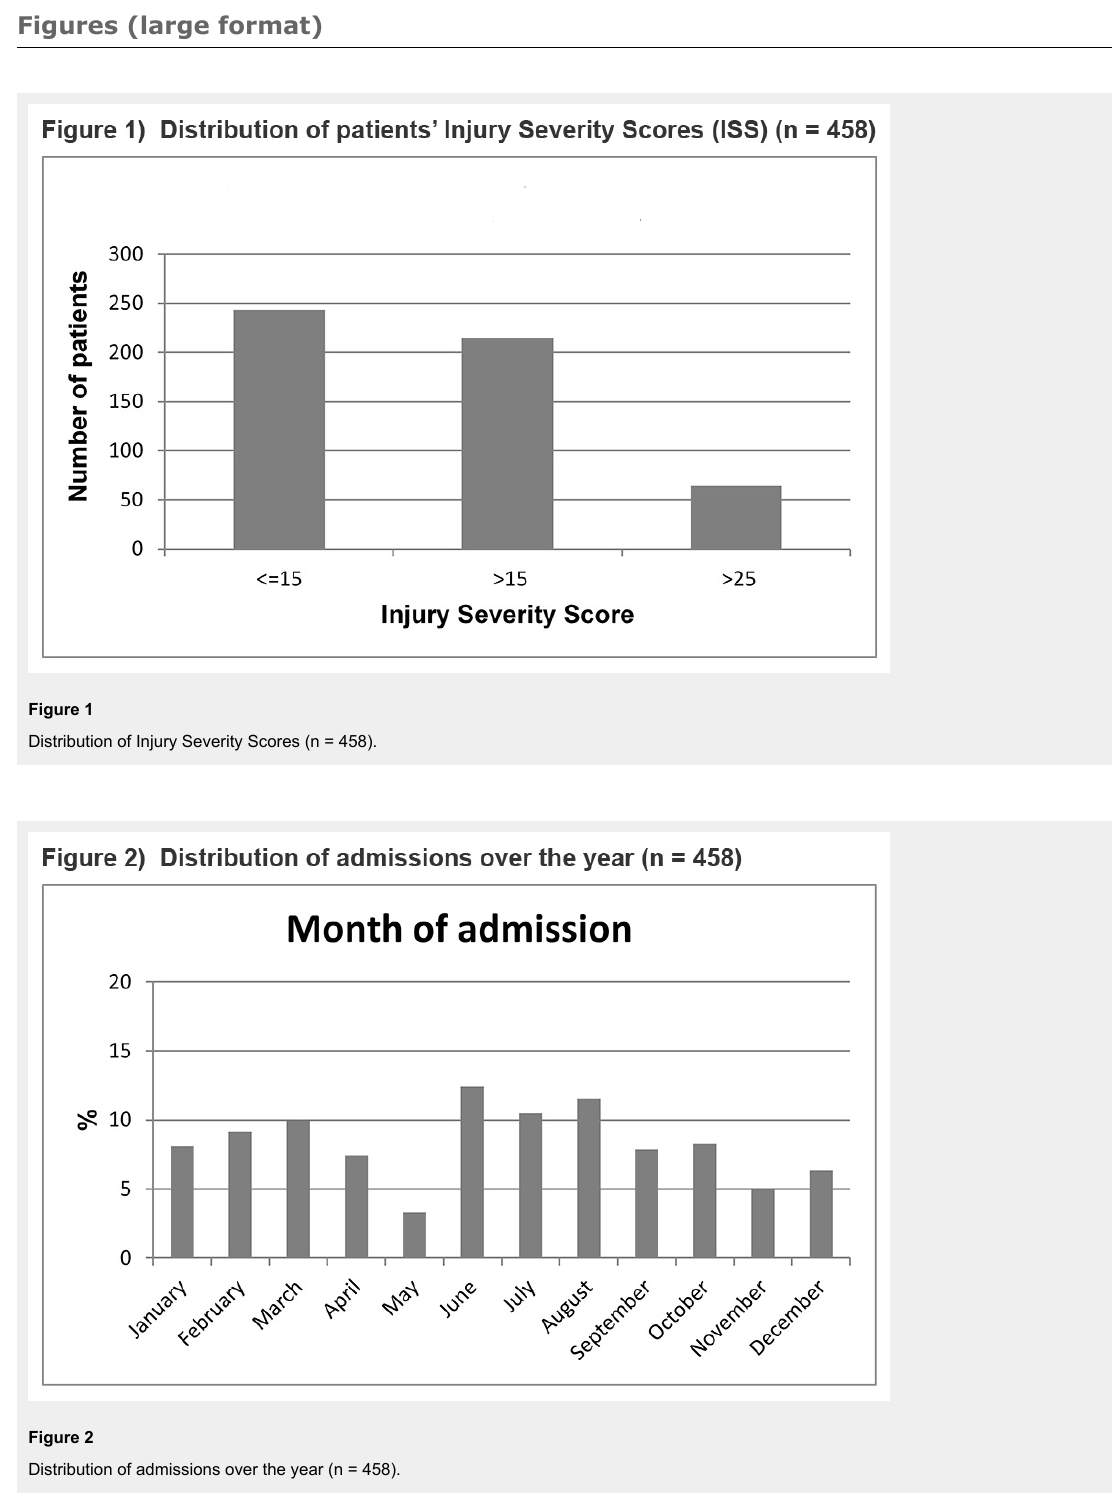
Figure 2 Distribution of admissions over the year (n =